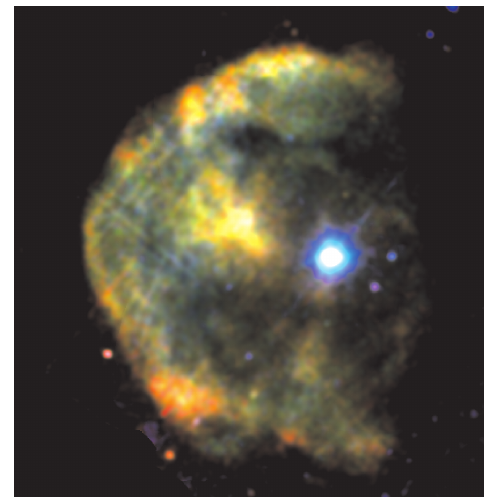
Figure 6: Mosaic RGB image of the SNR CTB 109 created from the XMM-Newton observations: red = 0.3 – 0.9 keV, green = 0.9 – 1.5 keV, blue = 1.5 – 4.0 keV (Sasaki et al., 2004).